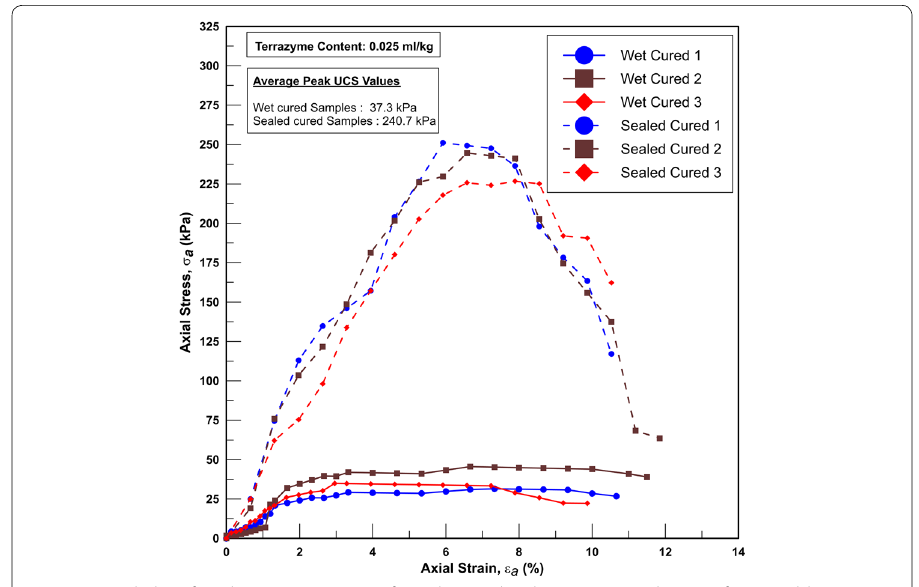
Fig. 5 Typical plot of axial stress versus strain for soil treated with a TerraZyme dosage of 0.025 ml/kg TerraZyme (ST1 dosage) at 60 days of ageing for both type of curing